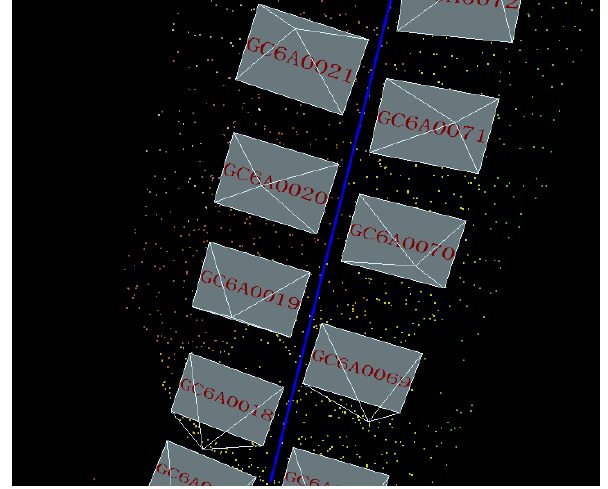
Figure 7. Image position on both sides along the power line.